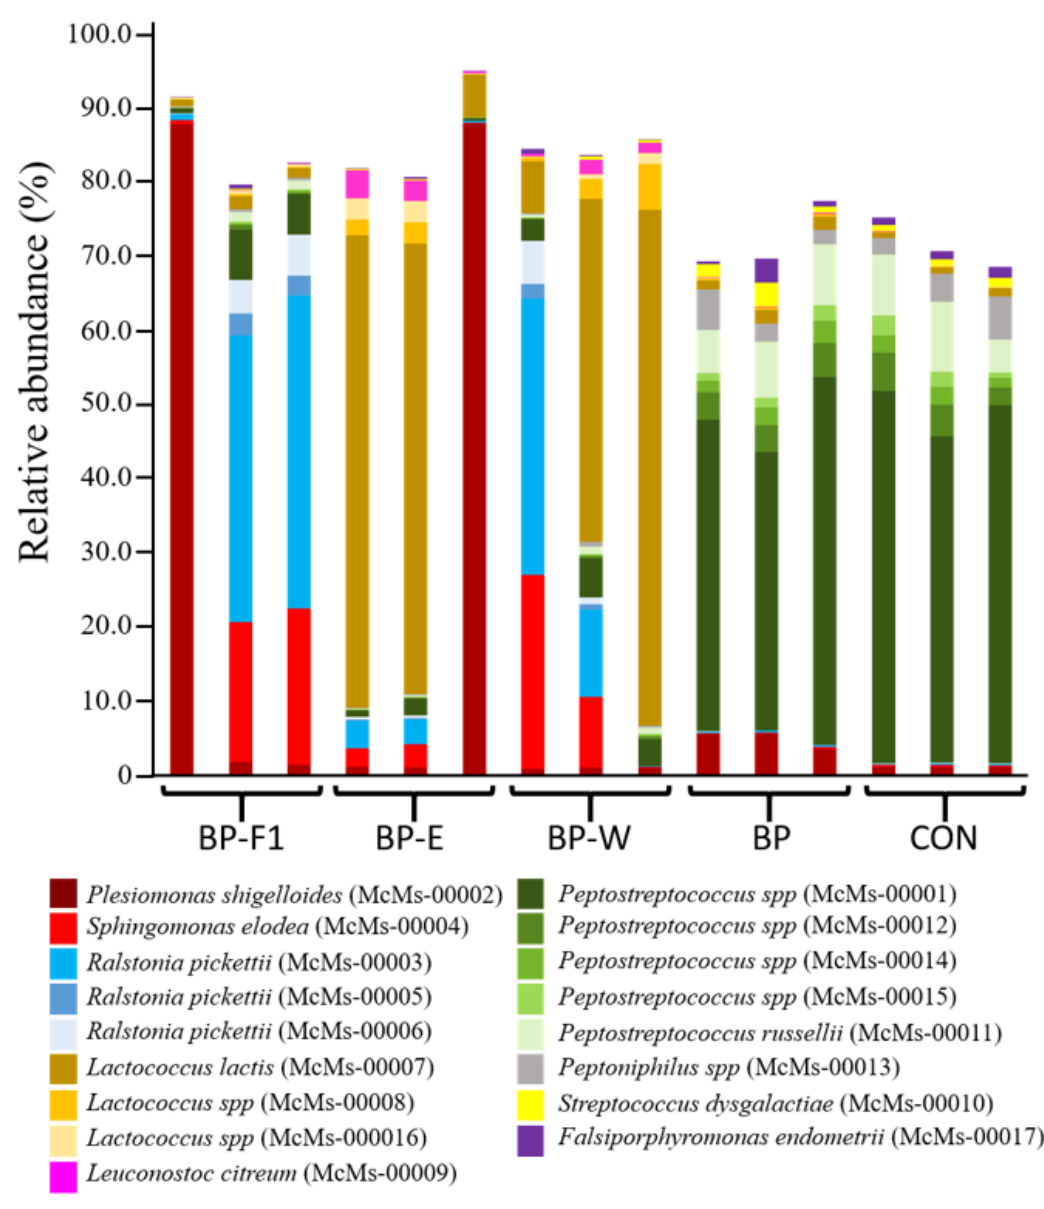
Figure 3. Histogram showing the relative abundance of the most highly represented intestinal OTUs in hybrid striped bass for five dietary treatments. OTUs showing 97% sequence identity or greater to their closest relative are represented by the full species name, while OTUs showing less than 97% identity to their closest relative are represented by their assigned